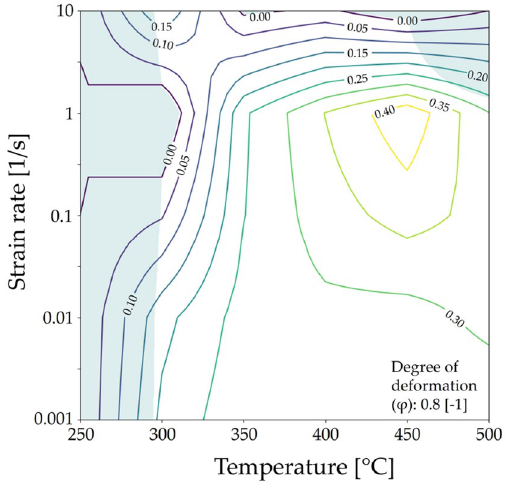
Fig. 3 Processing Map of AXMZ1000 alloy in the range of 250 to 500 ◦ C and 0.001– 10s − 1 , at a strain of 0.8 [− 1]. Contour lines show the power dissipation rate, shaded areas indicate instability